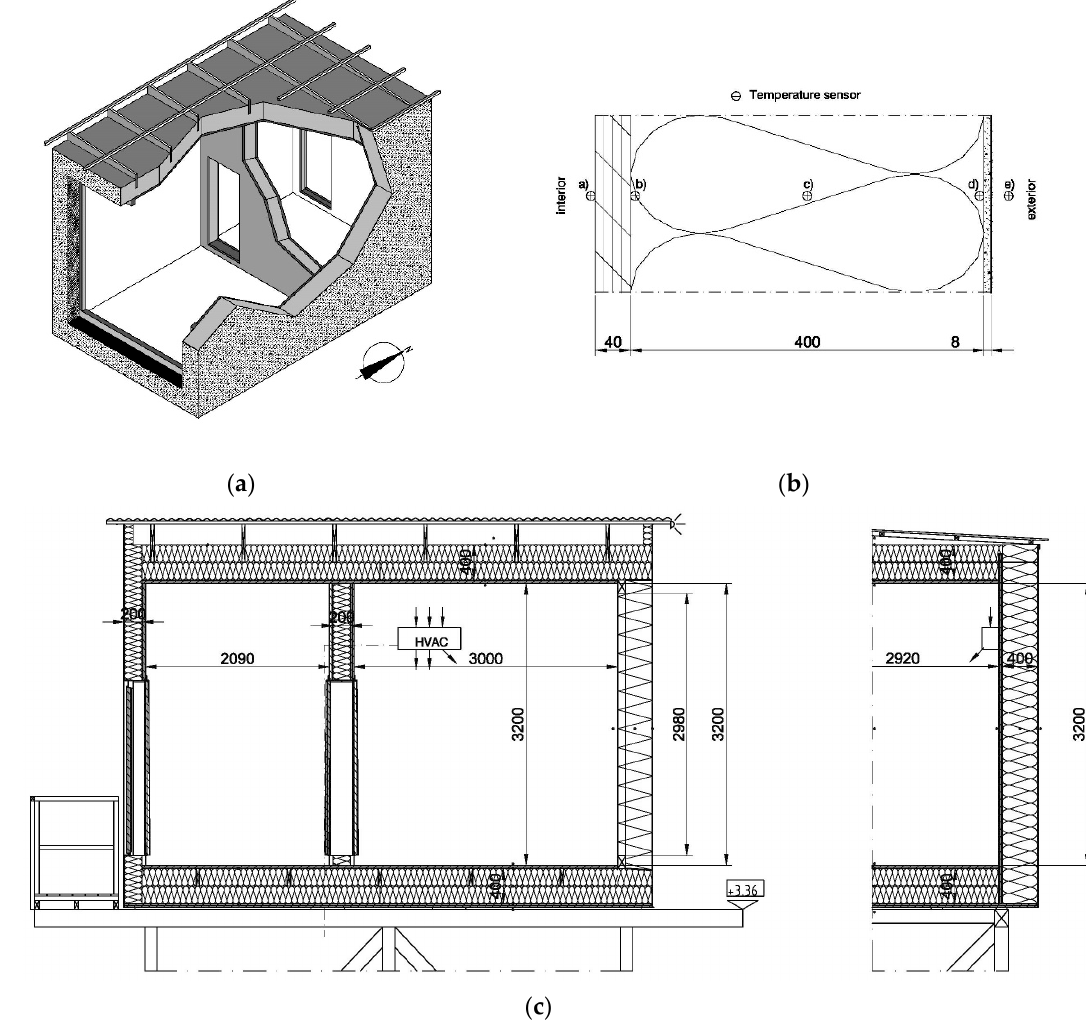
Figure 2. Geometry of the test cell (TC) with ( a ) isometric view, ( b ) sensor positioning detail for wall (other surfaces in the same manner) and ( c ) longitudinal (left) and cross section (right) of the TC.